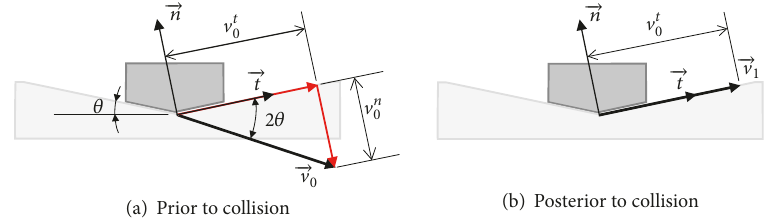
Figure 4: Instant speed vector of slider before and after the collision through the neutral position.